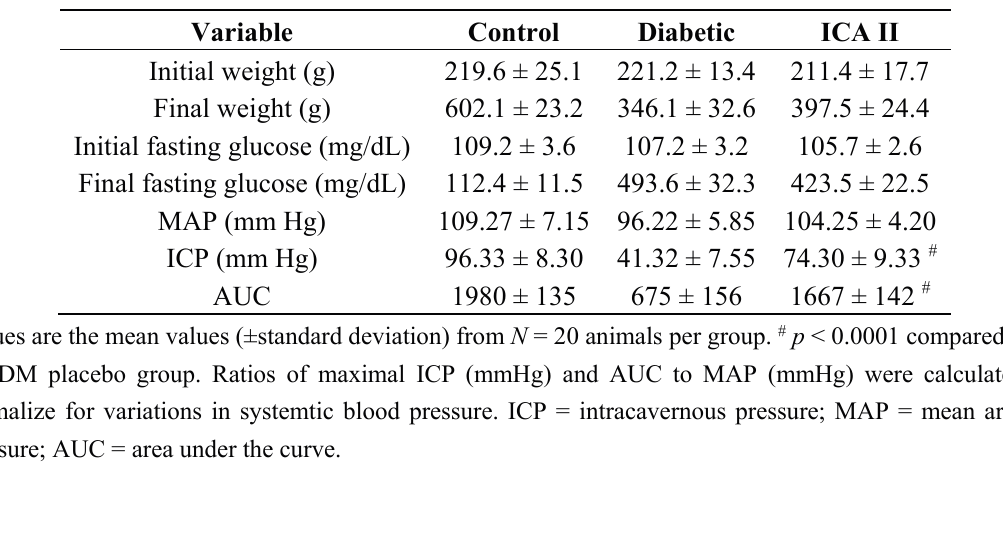
Table 1. Metabolic and physiological